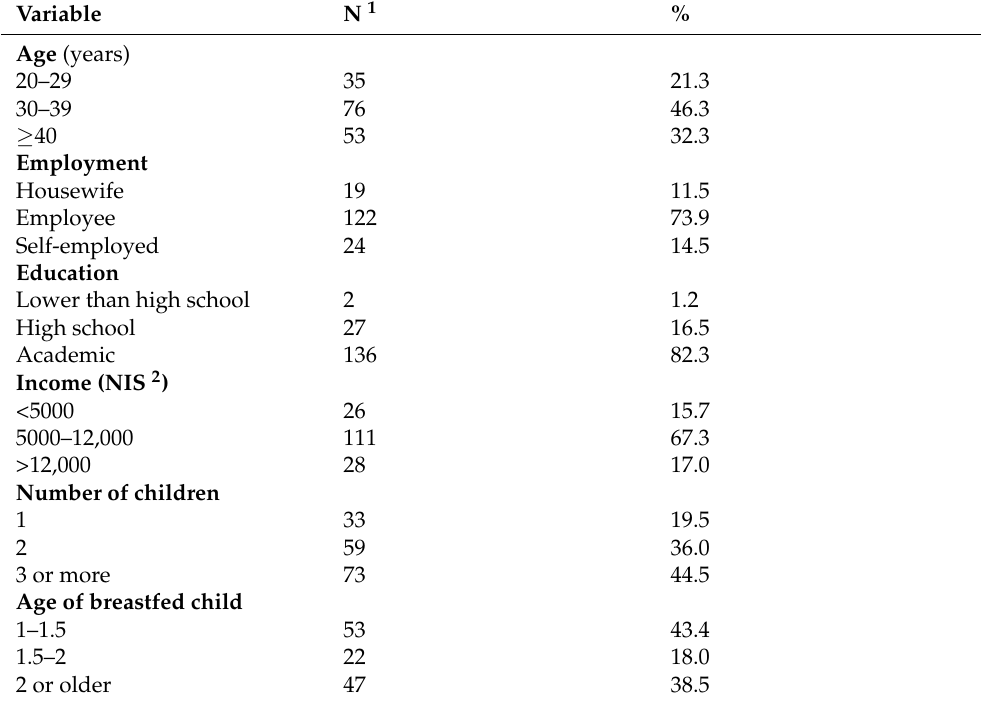
Table 1. Socio-demographic information of the sample (n =